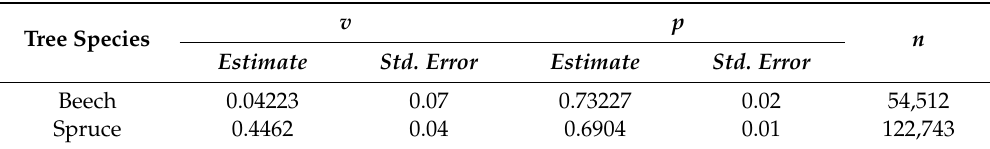
Figure 2. Assumed development of top height and mean diameter at breast height ( MDBH ) for the parametrization of the regulation approach within the exemplary simulation; parameters in Tables 2 and 3 (more detailed database information, see Appendices B.2 and B.3). Table 2. Estimates of the MDBH functions for European beech, Norway spruce (Equation (14); Section 2.2; more detailed database information, see Appendix B.2).